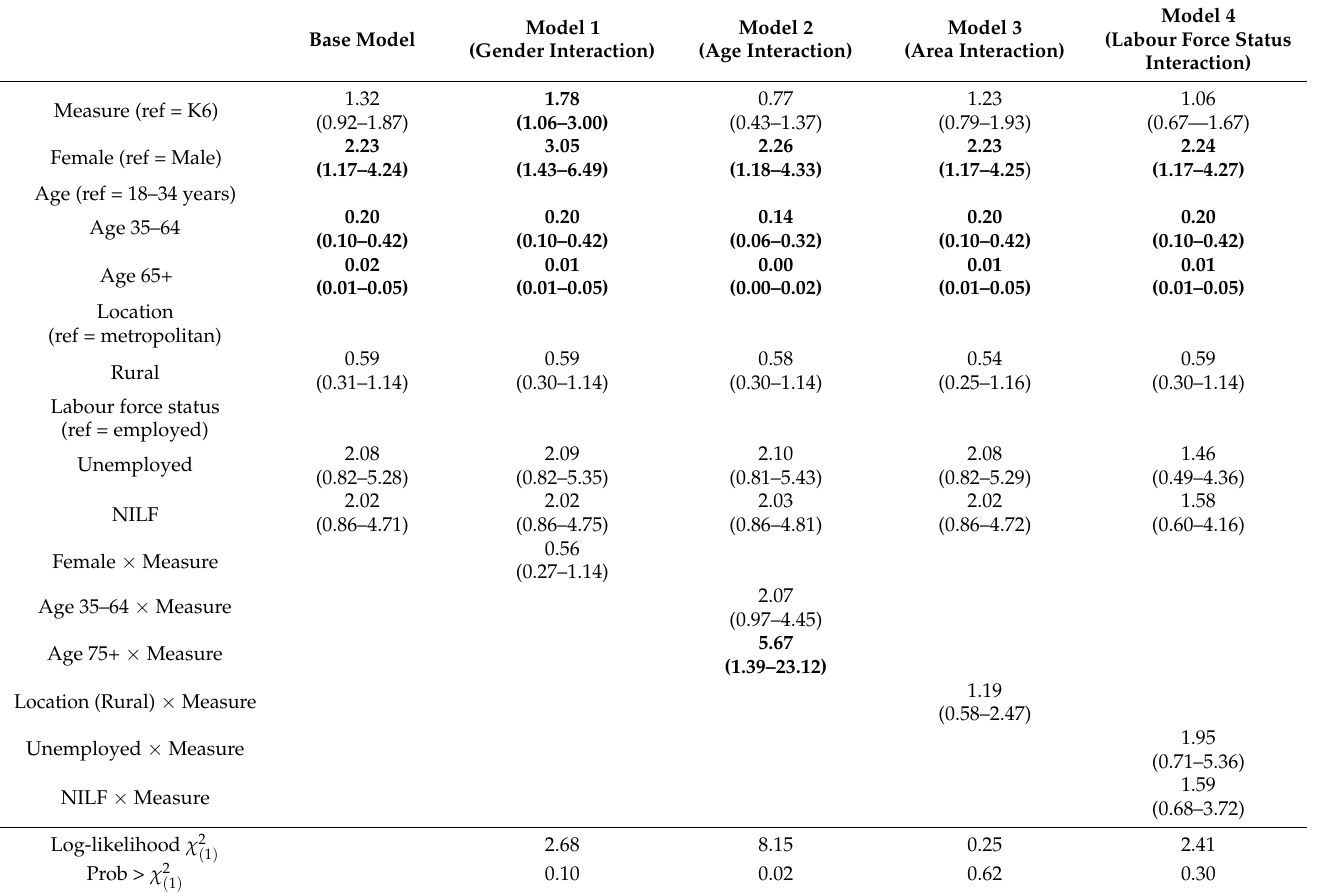
Table 3. Random-effects logistic regression results comparing the two binary mental distress measures derived from the Table 2. including baseline model and series of models adding the interaction between measure and each socio-demographic